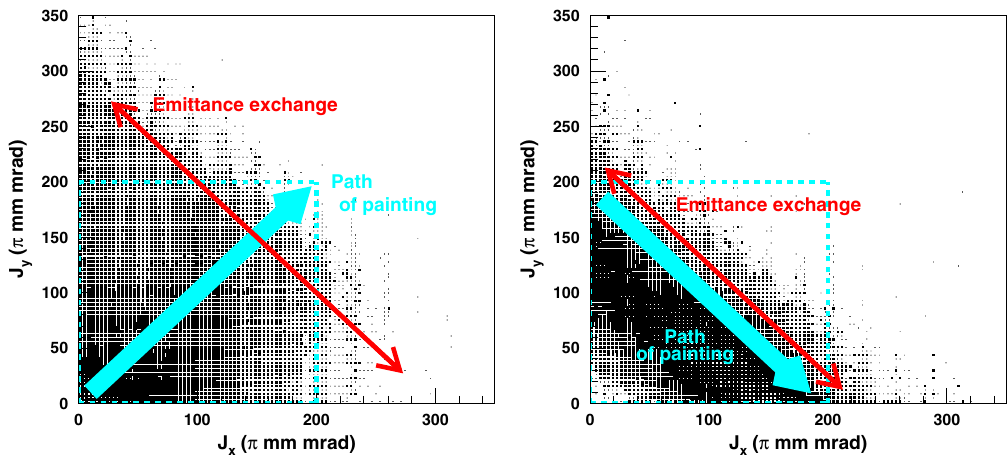
FIG. 36. Two-dimensional plots of ( J x , J y ) at the end of injection calculated for the beam intensity of 1 MW with correlated (left) and anticorrelated (right) painting of ϵ tp ¼ 200 π mm mrad.